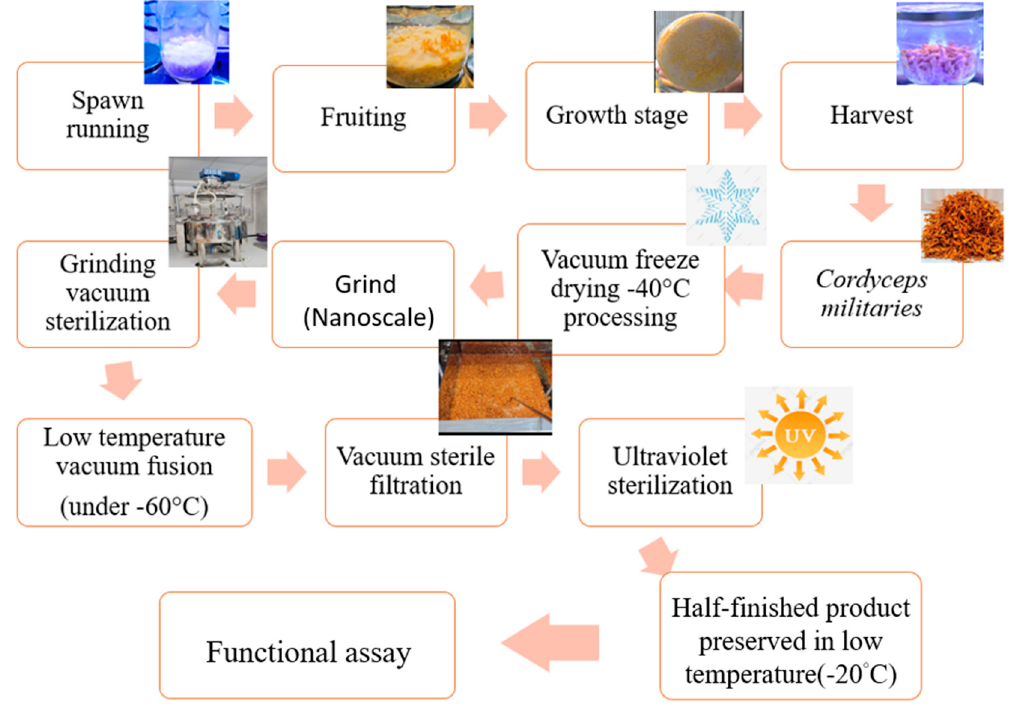
Figure 1. The extraction process using freeze-drying technology.